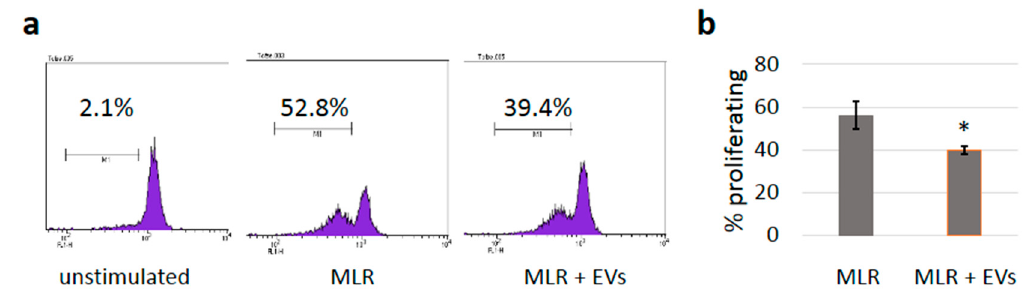
Figure 5. Mixed lymphocyte reaction (MLR). ( a ) Representative MLR experiment showing the induction of T cell proliferation by allogeneic PBMCs. PBMCs from one donor were labeled with CFSE to determine the proportion of cells undergoing cell division as each cell division reduces the mean fluorescence intensity by half. The analysis was restricted to T cells by gating on CD3-positive cells. ( b ) Summary of three independent experiments showing the percentage of proliferating cells in the presence or absence of sEVs (mean values +/- SD); a significant difference was found with p = 0.045 (Student’s t -test).